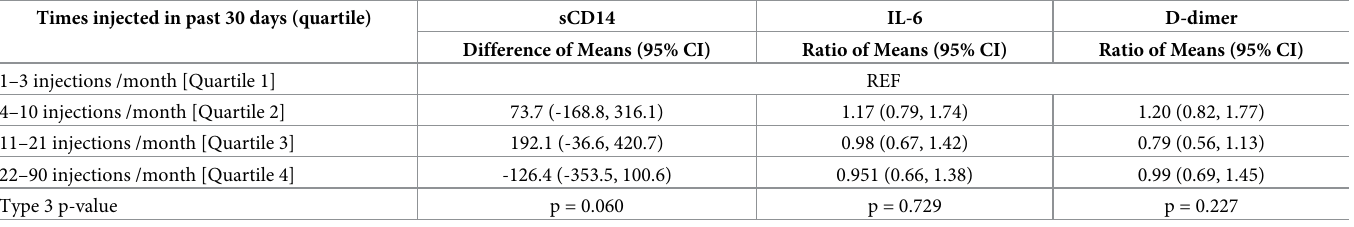
Linear mixed effects model adjusted for age, body mass index, HIV viral load, years from first HIV-positive test, alcohol consumption (including past 30 day), alcohol use